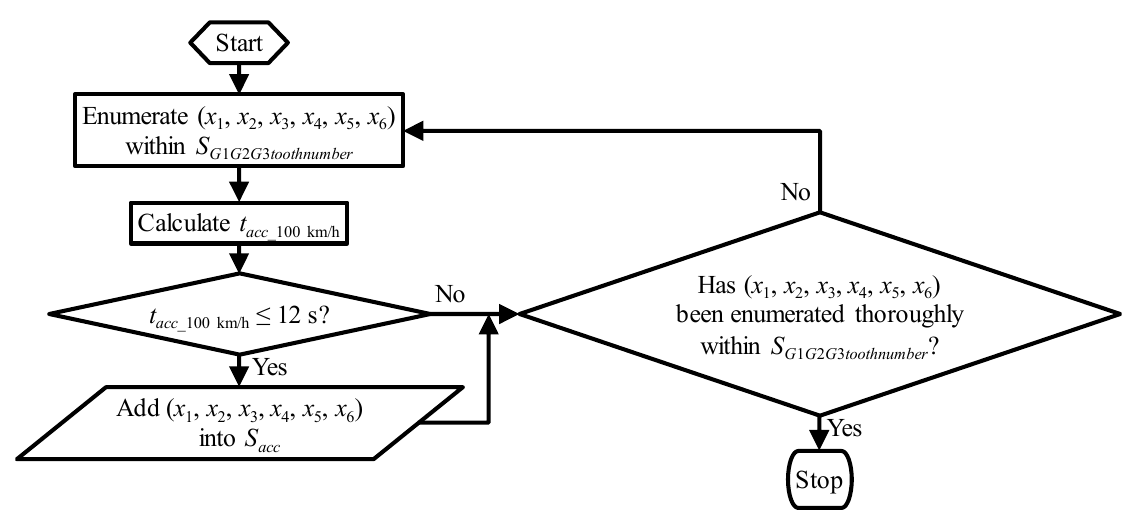
Figure 7. Scheme of the enumeration for the acceleration time.